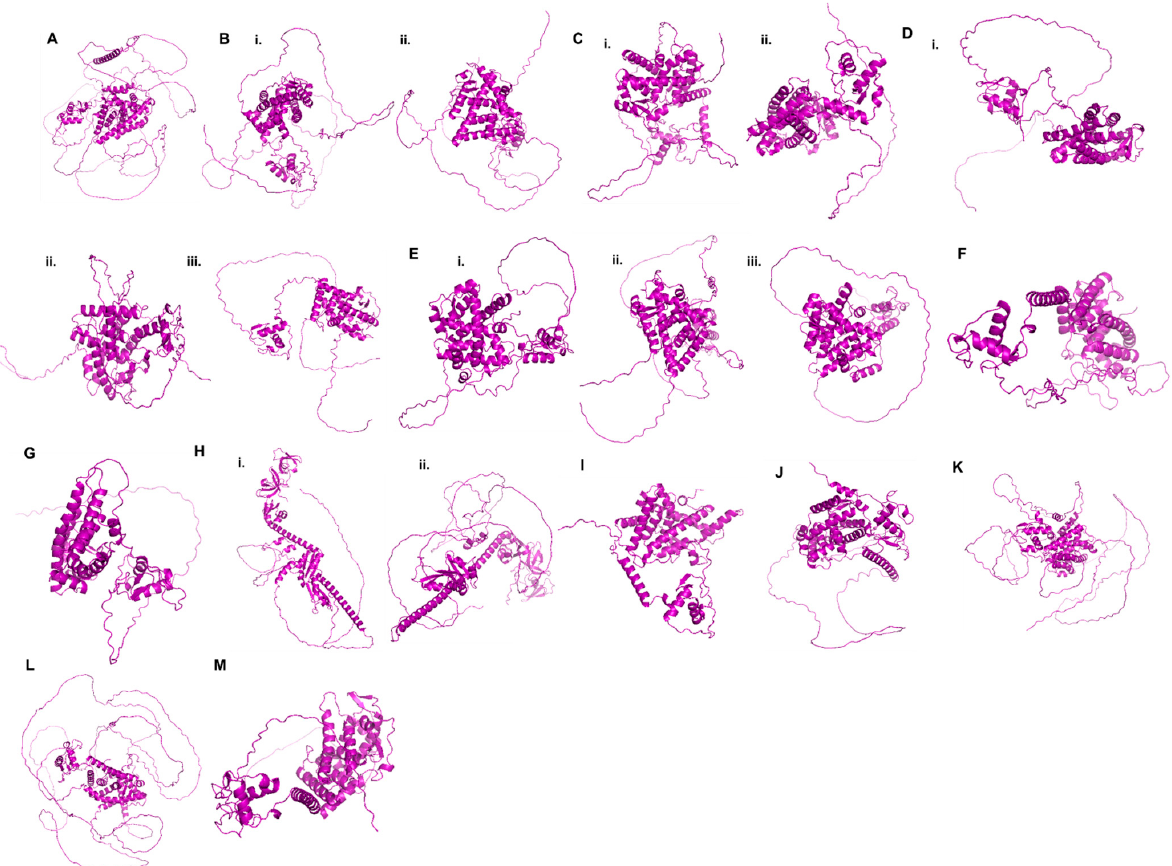
Figure 3. Structural representation of different NRs involved in lung cancer : ( A ) AR (Uniprot